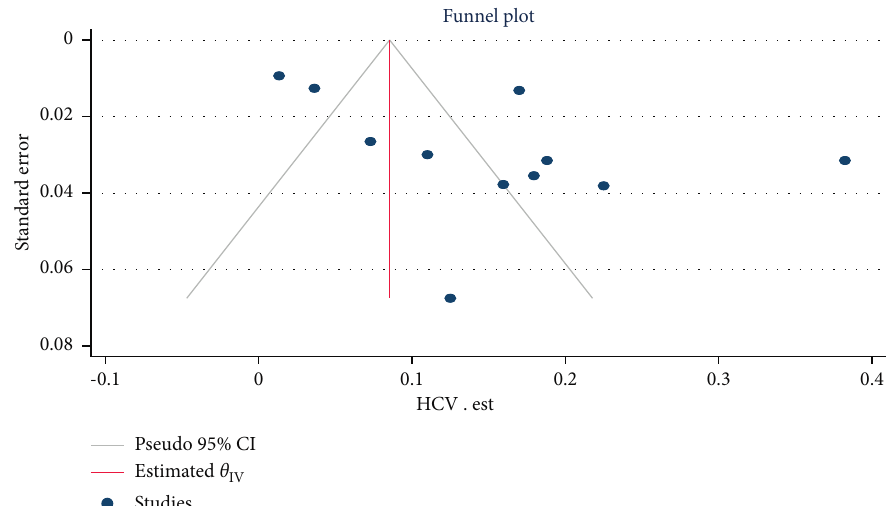
Figure 3: Funnel plot for assessing publication bias across HCV infection estimates among chronic liver disease patients in Ethiopia, 2021.